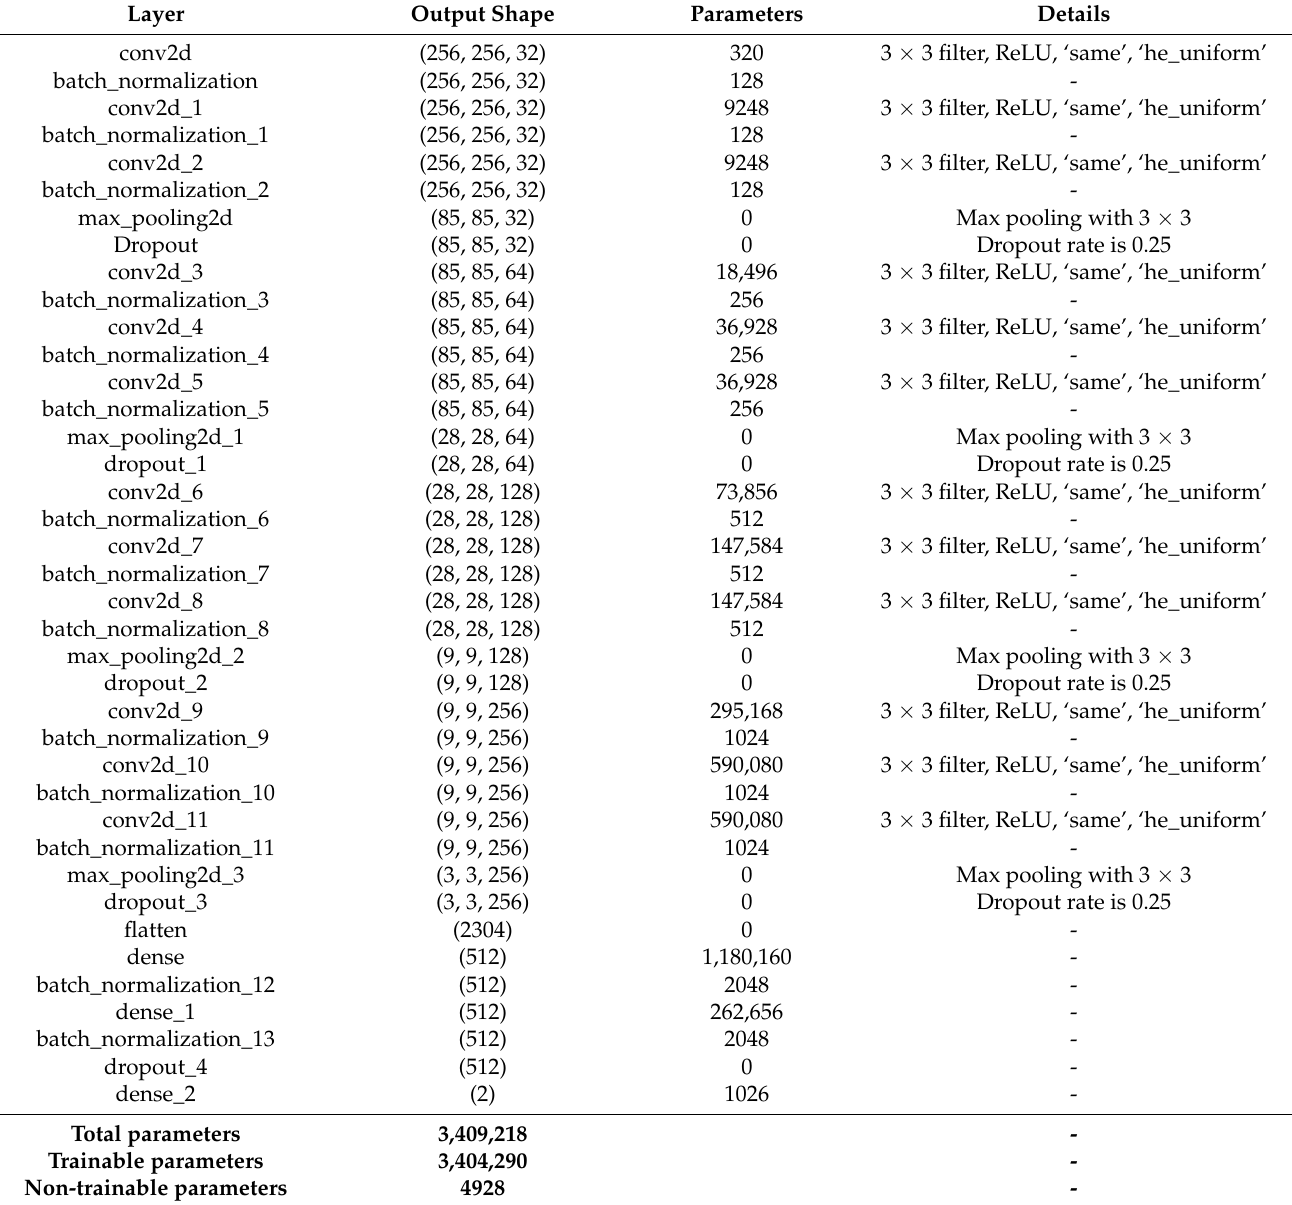
Table 6. The technical architecture details the proposed sequential deep learning based on